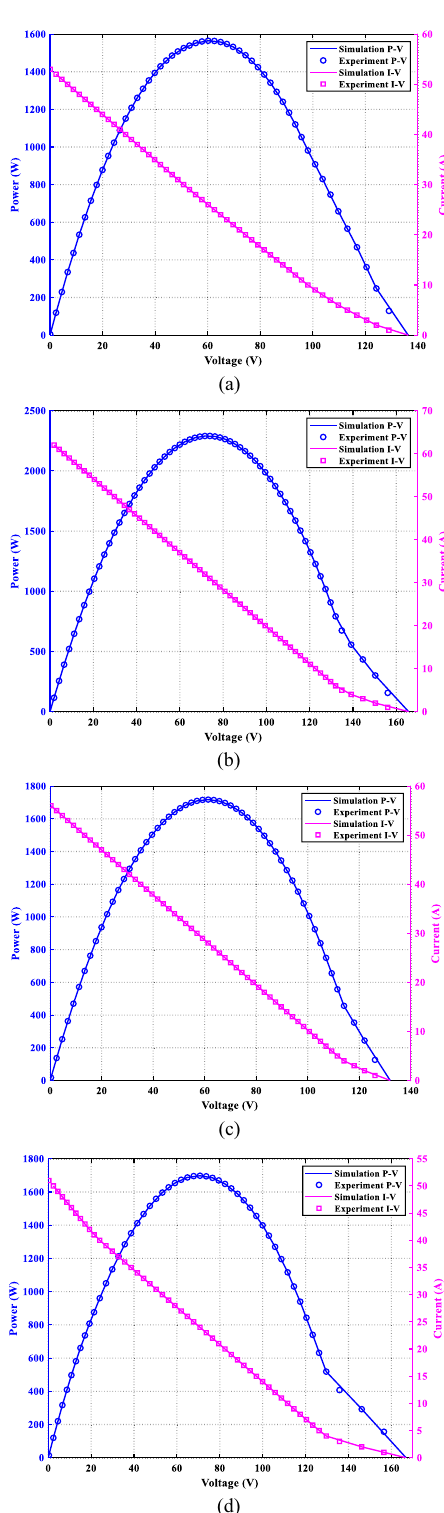
Fig. 16 Output characteristics of (15 and experiment under various HgTDs optimized by ACS: a diagonal, b outer, c inner, and d